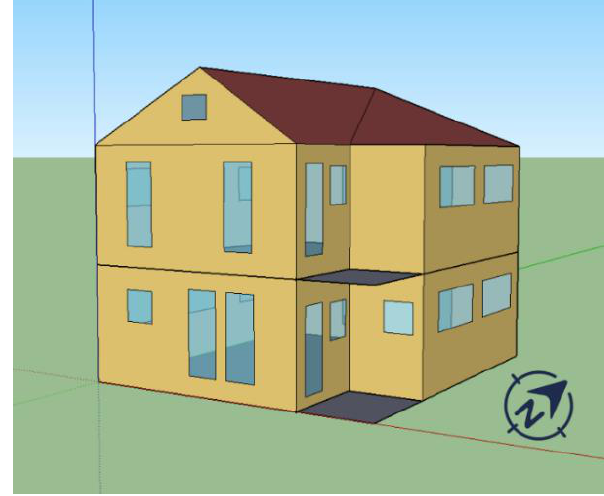
Figure 7. Sketch of the simulated building.